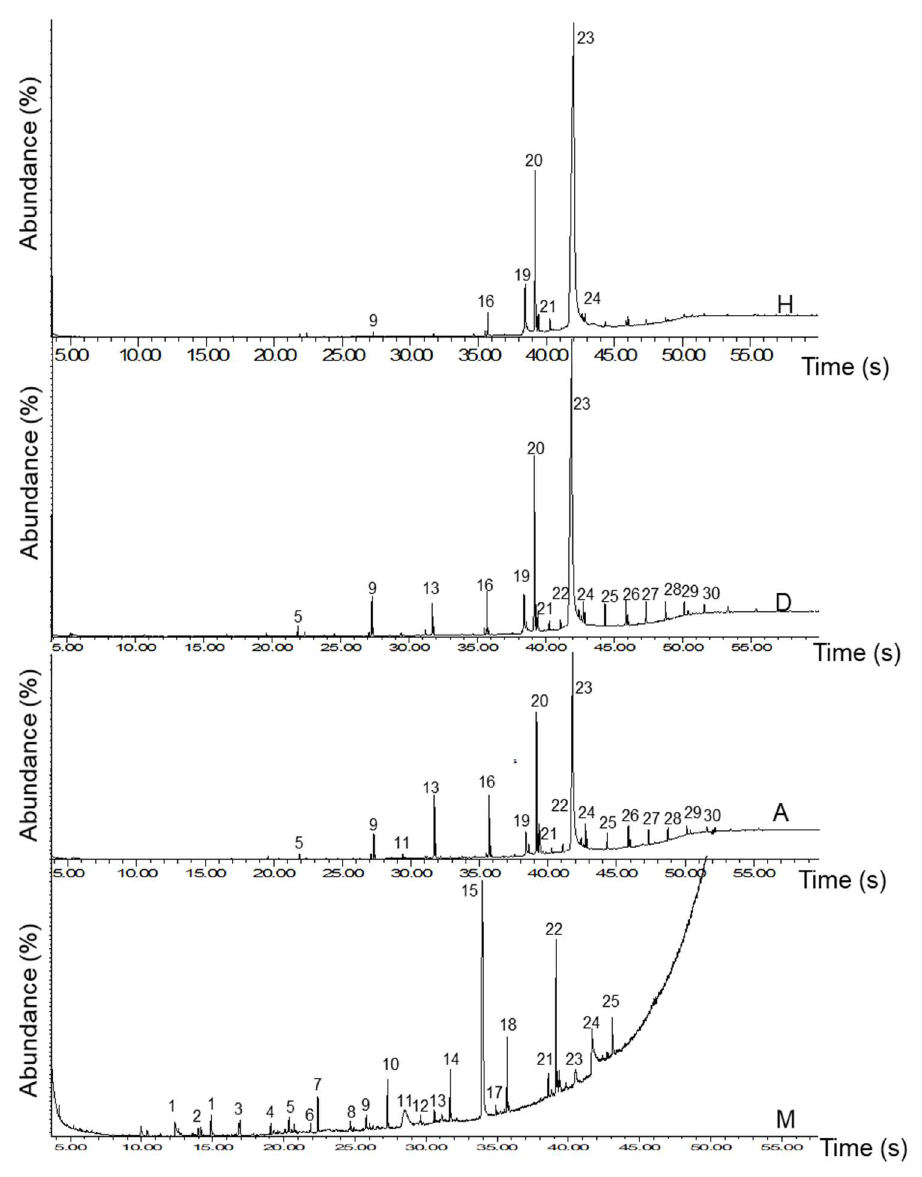
Figure 1. Total ion chromatogram of the MOS oil extracts. H = hexane, D = dichloromethane, A = Acetone, M = methanol.